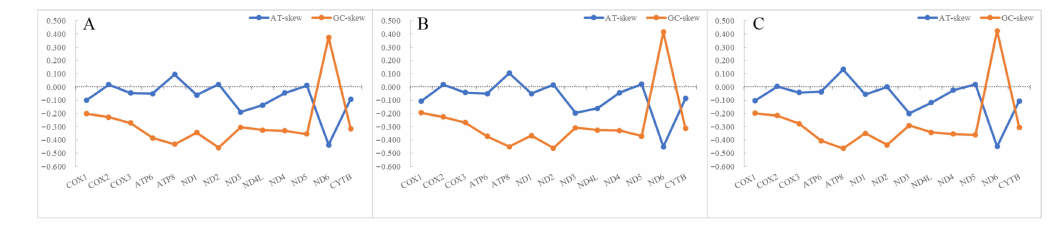
Figure 6. The nucleotide skewness of three species of Sebastiscus . ( A ) S. tertius ; ( B ) S. albofasciatus ; ( C ) S. marmoratus . The incomplete T–/TA- of the stop codon is not